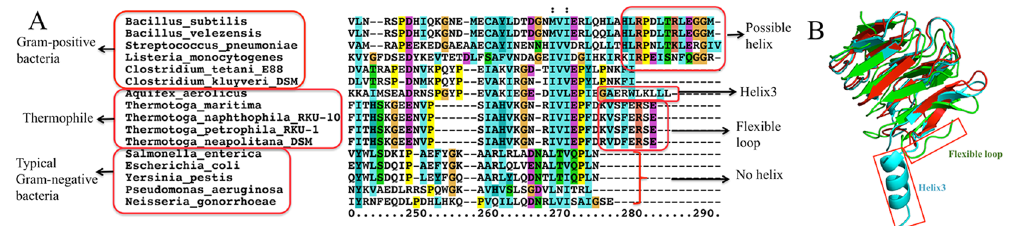
Figure 6. Sequence alignment of MinC from different organisms (240–291 aa) and overall structures of superimposed dimeric Aa MinC CTD , Tm MinC CTD and Ec MinC CTD . ( A ) The C-terminal tails of MinC of the typical Gram-negative bacteria are highly similar. However, The C-terminal tails of MinC from several bacteria belonging to Thermophile (such as A. aerolicu and T. maritima ) and several typical Gram-positive bacteria (such as B. subtilis ) are longer than the Gram-negative bacteria. Alignment was performed using the program ClustalX 2.1 . ( B ) As seen from the structures, Tm MinC CTD has a flexible loop at its C-terminal tail and Aa MinC CTD has a helix3 at its C-terminal tail (blue: Aa MinC CTD , green: Tm MinC CTD , red: Ec MinC CTD ).